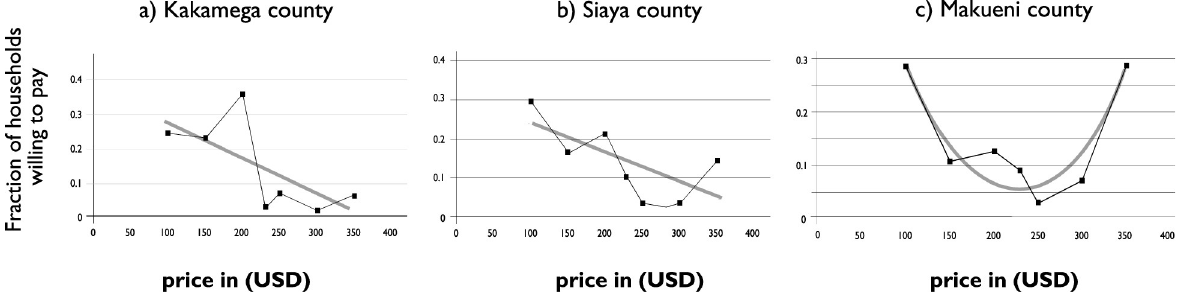
Fig 4. a-c. Demand curves for SAFI latrines by county